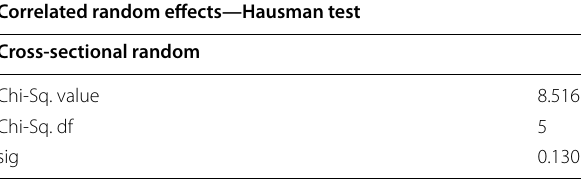
Table 7 Test cross-sectional random effects. Source: Software